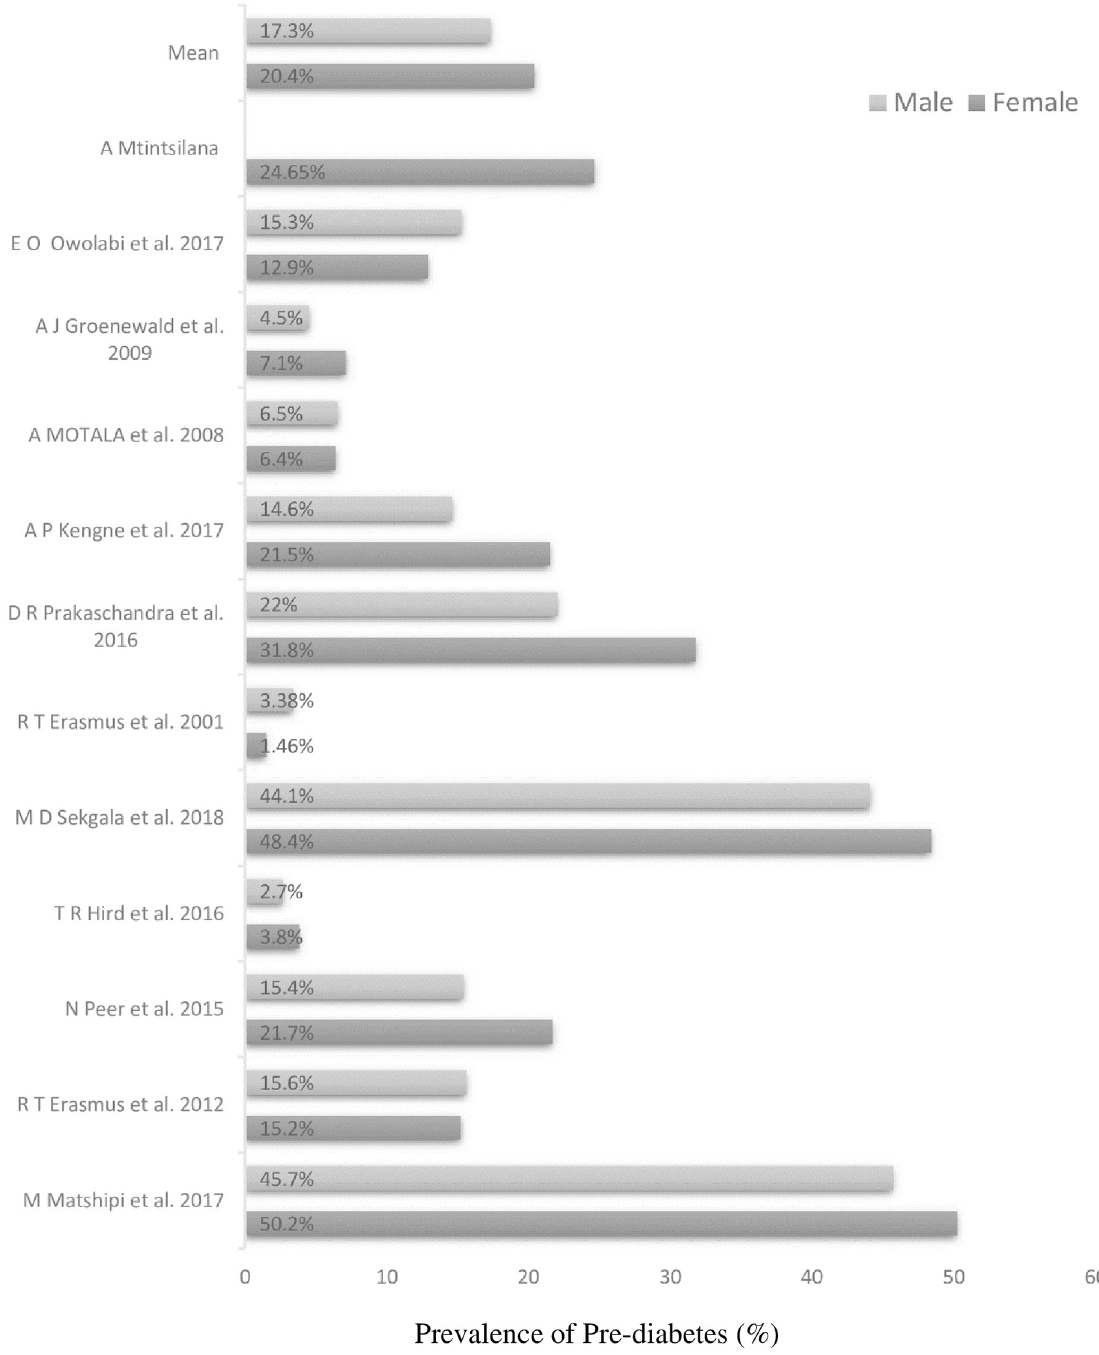
Fig 3. Presents the prevalence of pre-diabetes stratified by sex in the South African population. The study conducted by A Mtintsilana only had female participants. The overall female-to-male ratio is 1,18.